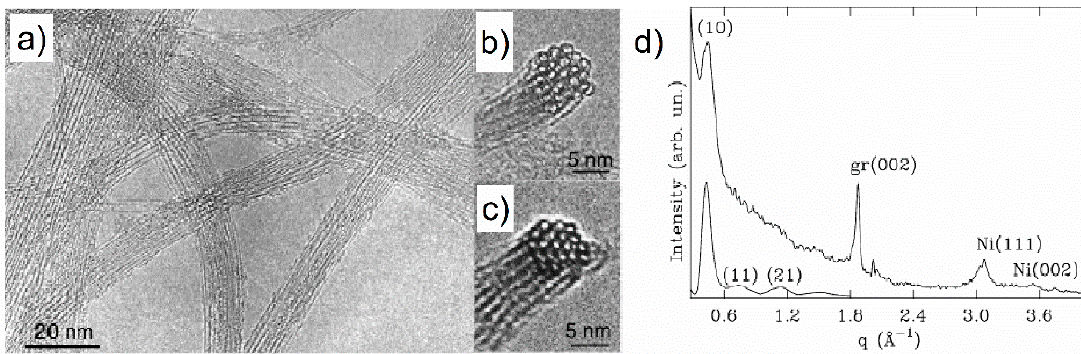
Figure 31. ( a ) HRTEM image of CNT ropes projected perpendicularly to their axis and ( b , c ) images of a rope projected along its axis. ( d ) Experimental powder XRD profile of a sample of SWCNT ropes produced by the arc-discharge technique (top curve) and theoretical diffraction profile computed for an ensemble of ropes with average diameter 1.34 nm and average number of tubes 25. Reproduced with permission from Lambin et al. [95]. Copyright Elsevier, 2002.